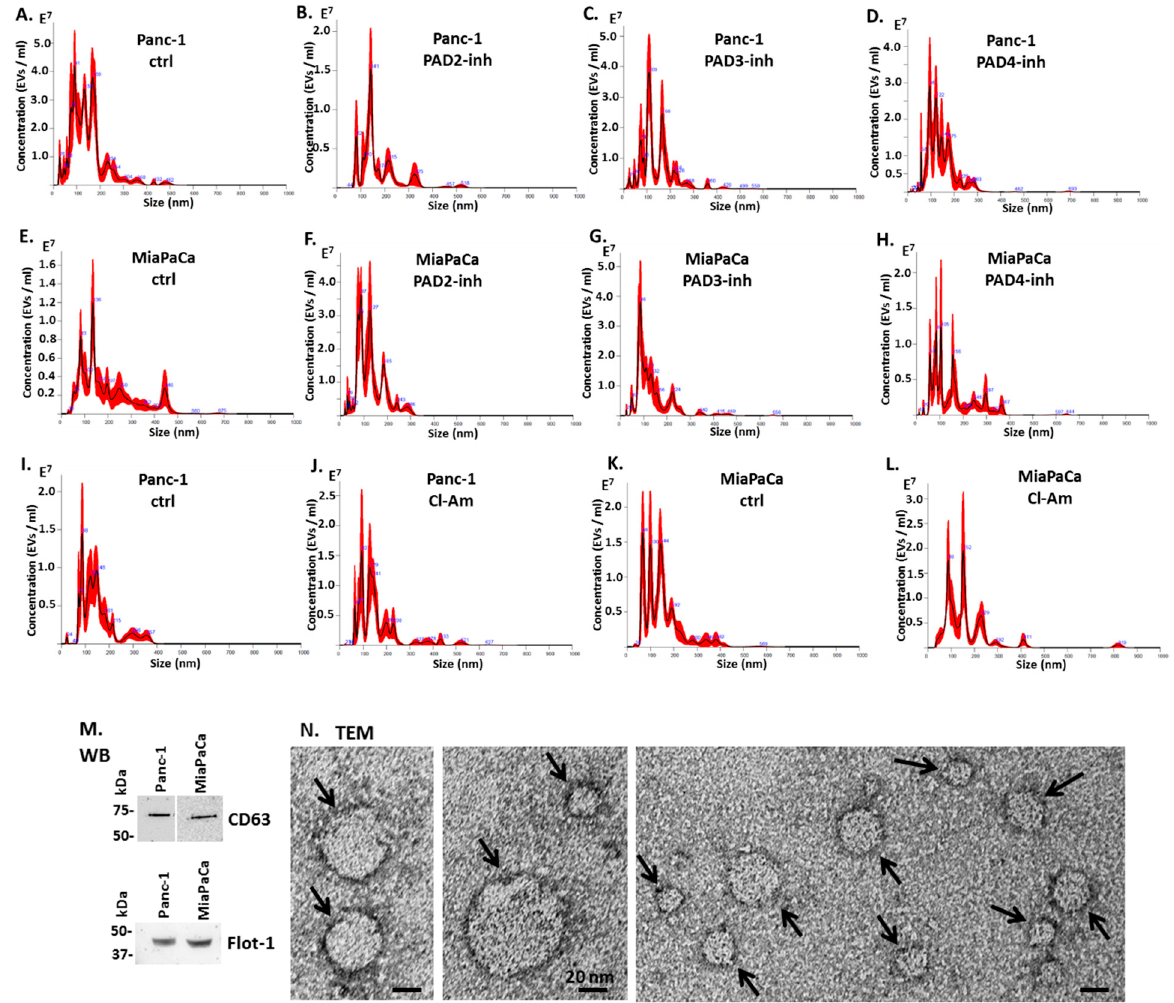
Figure 4 . Nanoparticle tracking analysis (NTA) size distribution profiles of EVs released from Panc-1 and MiaPaCa-2